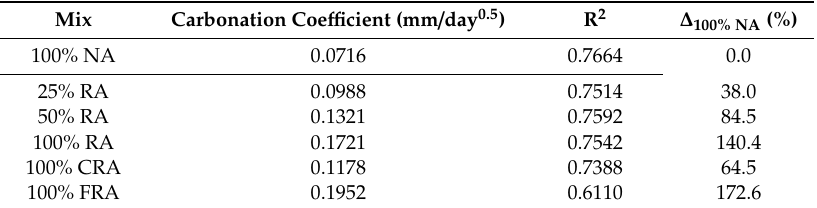
Figure 18. Depths of carbonation as function of Table 11. Carbonation coe ffi cients for all mixes.